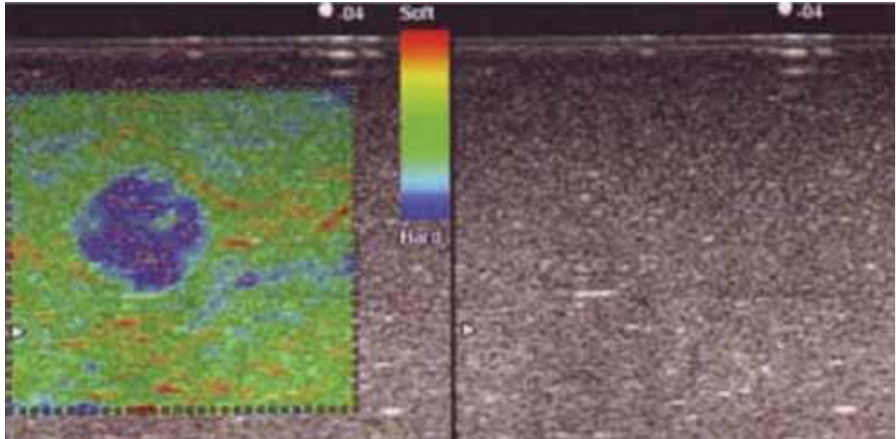
FIGURE 4. Displacement is encoded in different colors: “hard” tissue is blue and “soft tissue red. Conventional ultrasound image of phantom is homogenous, and shows only light shadowing dor- sal to unde(cid:144) ned structure. Rtse reveals well-de(cid:144) ned, hard structure.